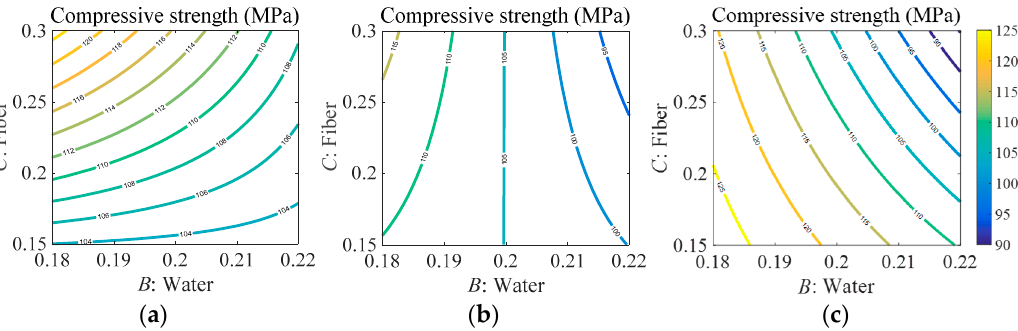
Figure 6. Contour plots of the w/b ratio ( B ) and basalt fiber content ( C ) on compressive strength. ( a ) A = 0.9 ， D = 0.2; ( b ) A = 1 ， D = 0.3 and ( c ) A = 1.1 ， D = 0.4.